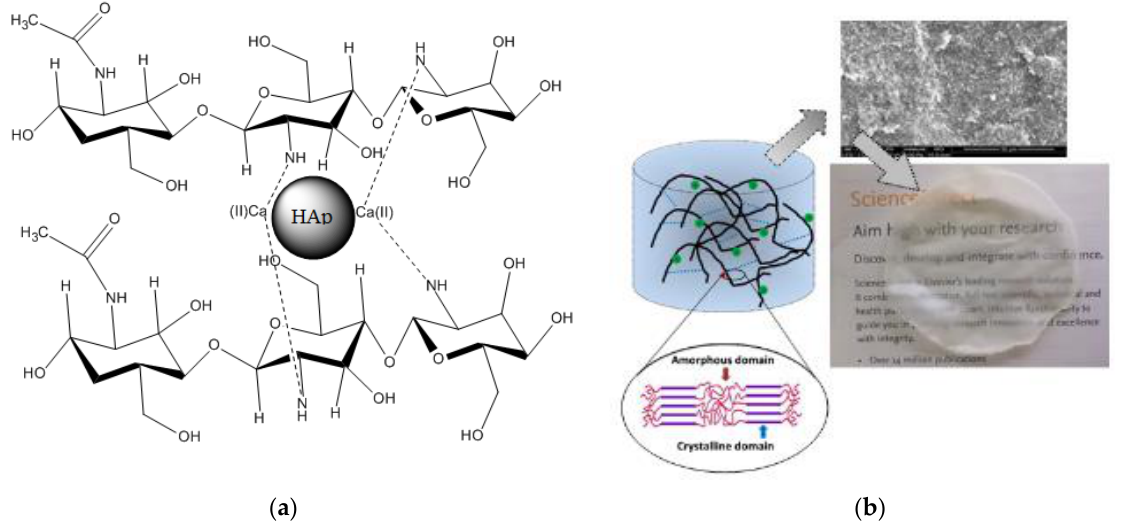
Figure 7. ( a ) Schematic model illustrations the relations between the NH groups of CTs and Ca of hydroxyapatite; ( b ) A SEM image, a photo of the obtained HAp/CTs membrane and a schematic diagram of membrane materials overlaying.